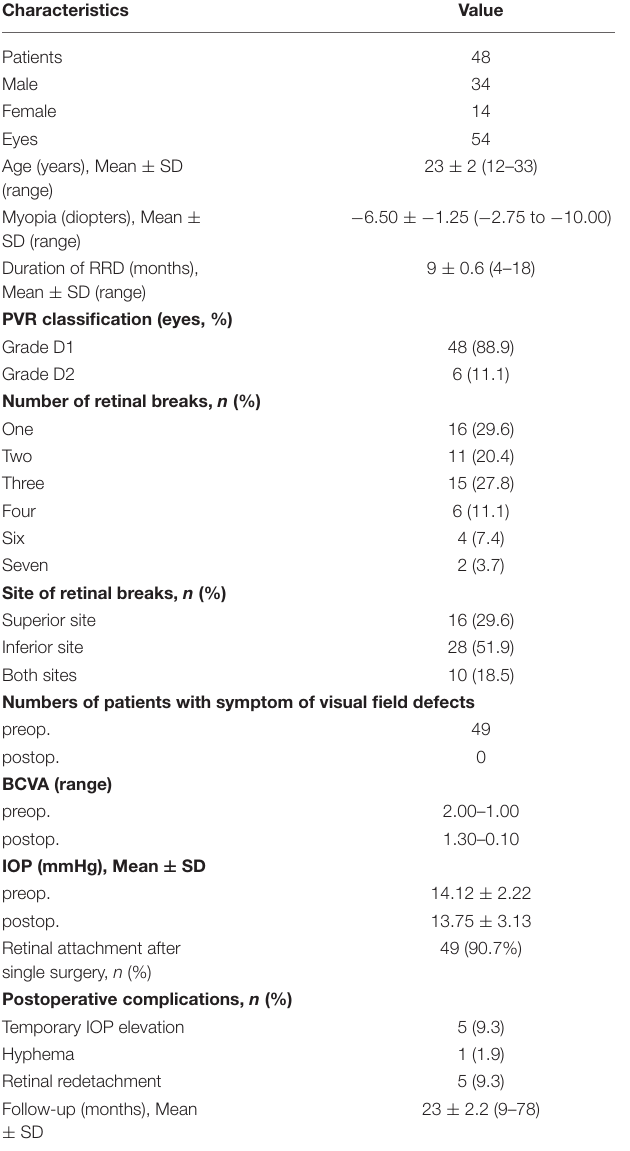
TABLE 1 | Characteristics of the young adult patients with chronic total RRD. Characteristics